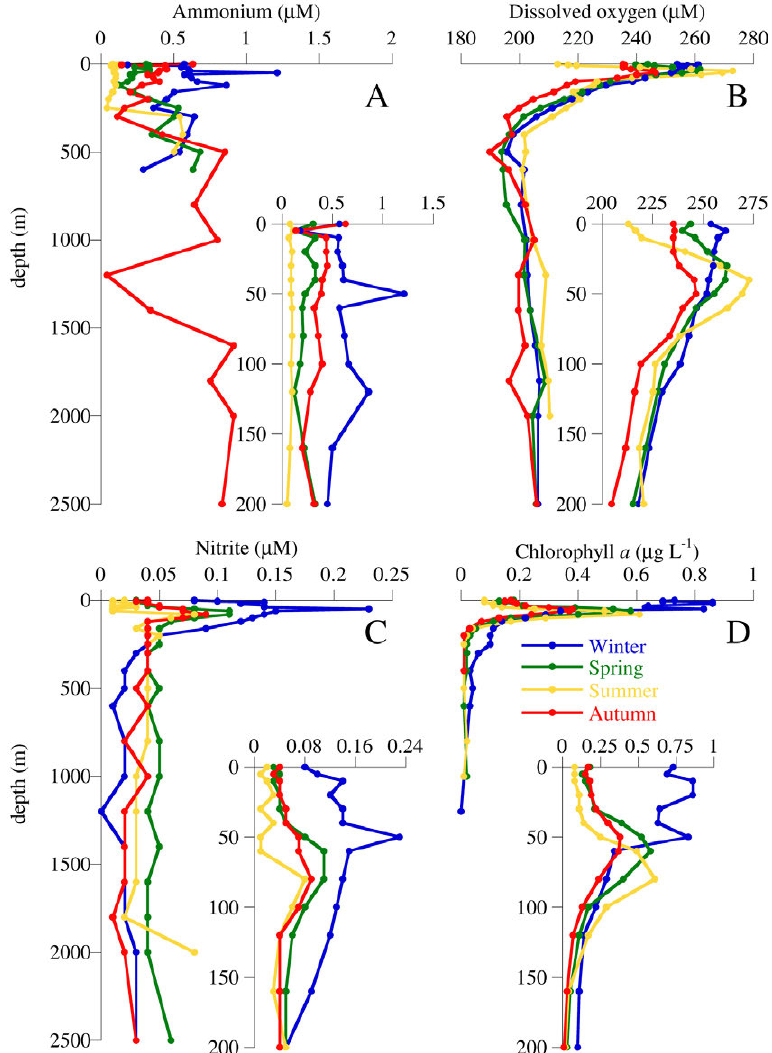
Fig. 4. – Seasonal depth concentration profiles of ammonium (A), dissolved oxygen (B), nitrite (C) and chlorophyll a (D) in open sea stations (bottom depth>200 m) of the Catalan Sea. The first 200 m are enlarged in the small